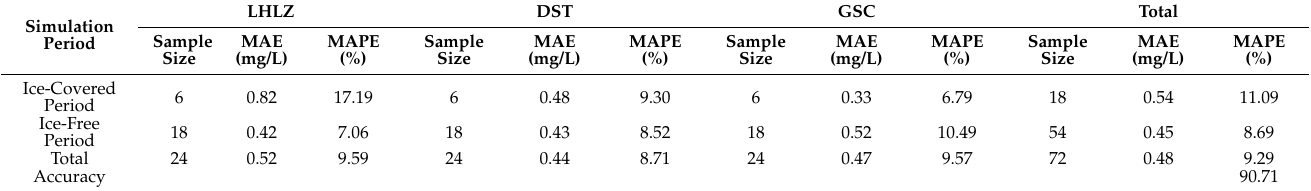
Table 2. Statistical results for COD Mn between simulated and observed values in Jingpo Lake model.